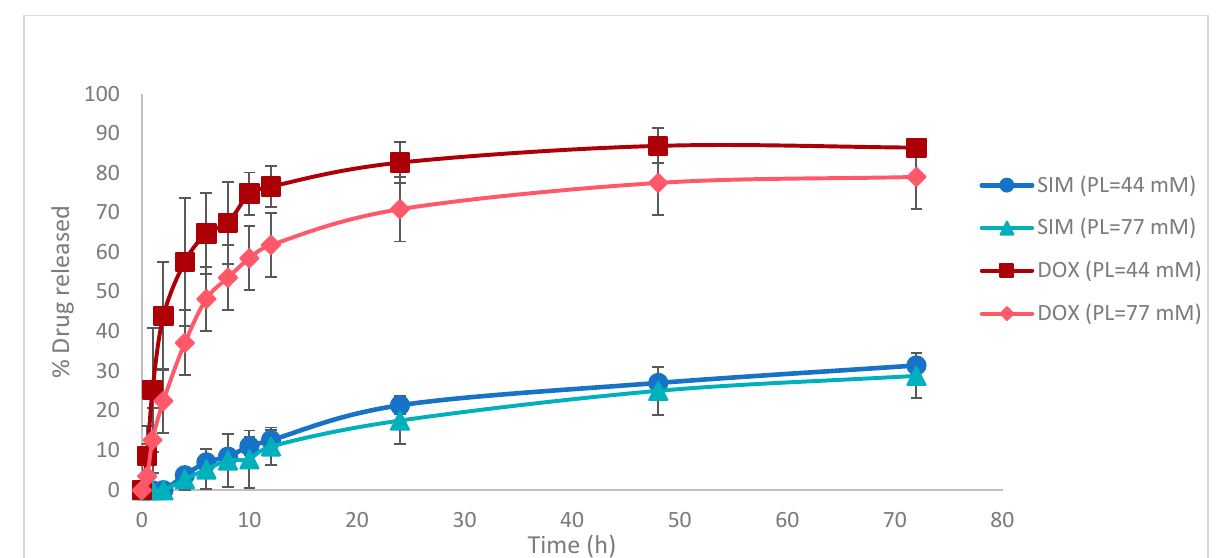
Figure 8. SIM and DOX release profiles from formulations with different PL concentrations. The results are expressed as % of drug released from the total drug entrapped concentration/ ml of liposomes, at different time intervals. The vertical bars at each sampling point represent the standard deviation of three samples.